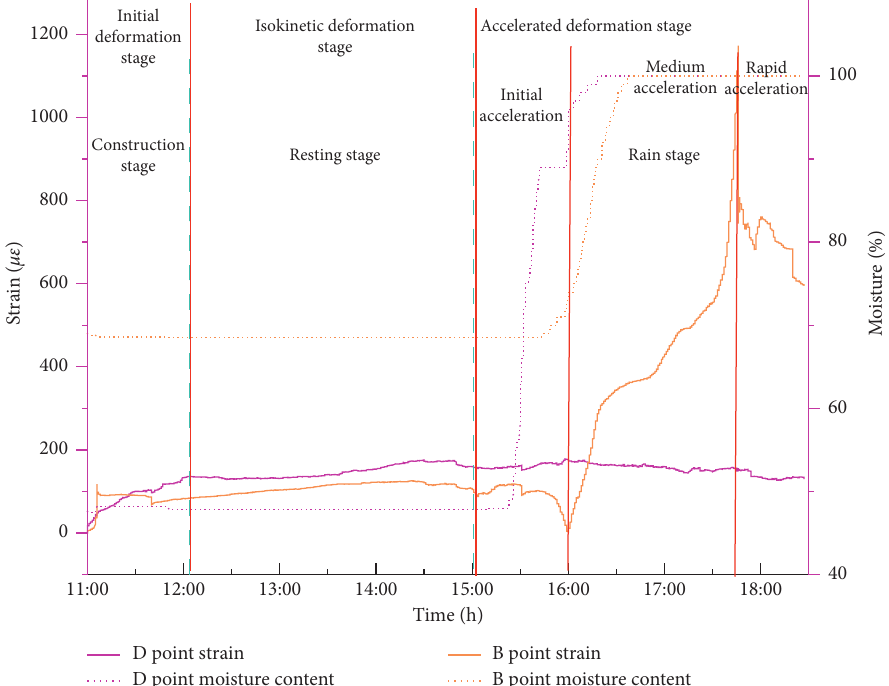
Figure 13: B, D measuring points strain-water content time history curve.